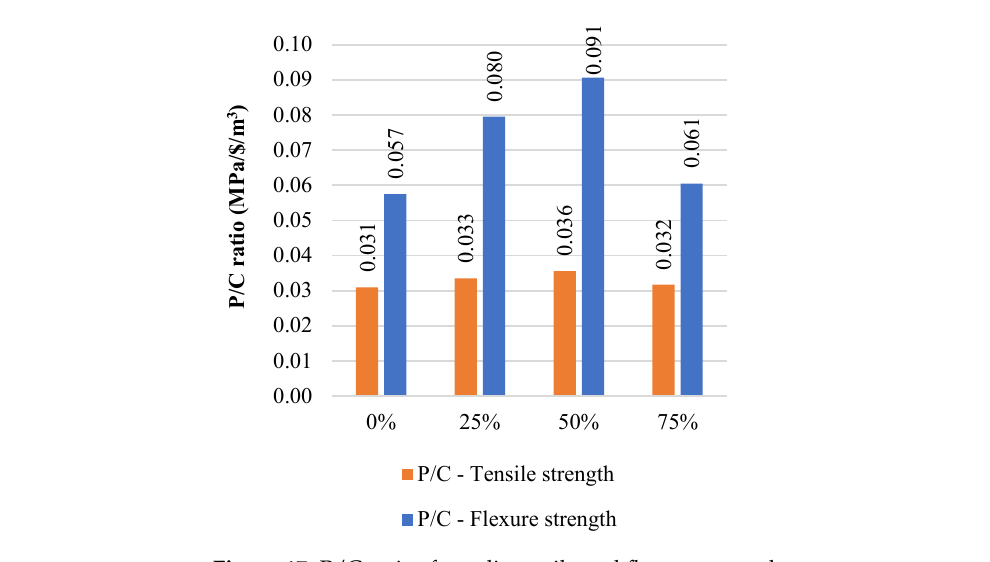
Figure 16. P/C ratios for compressive strength.